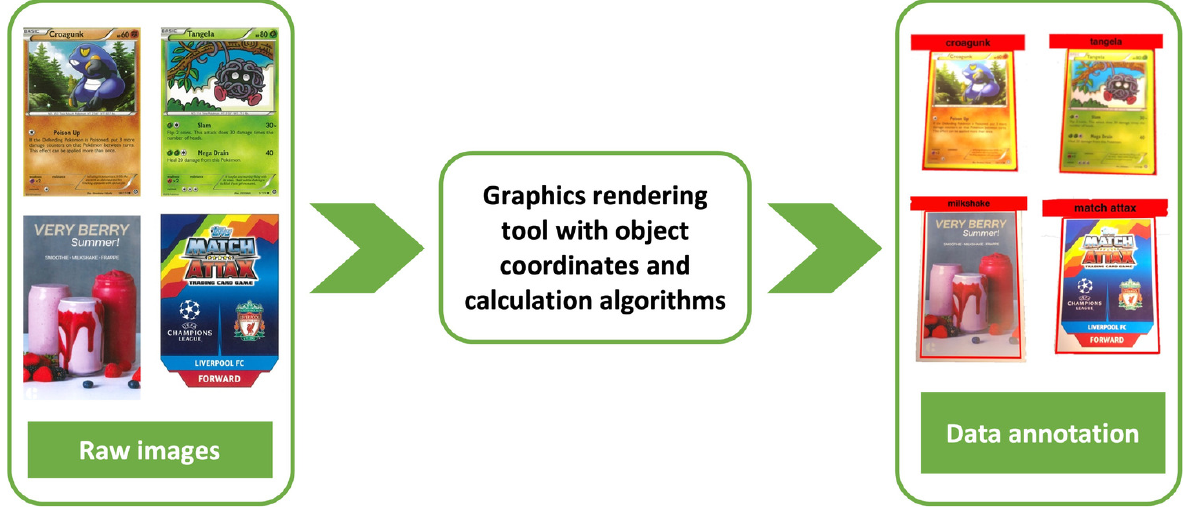
Figure 6. The raw images ( left ) are processed through the graphic rendering unit and the augmentation algorithms to output the class name and coordinates for further deep learning neural network training ( right ). Table 1. Time requirements for the manual and synthetic data